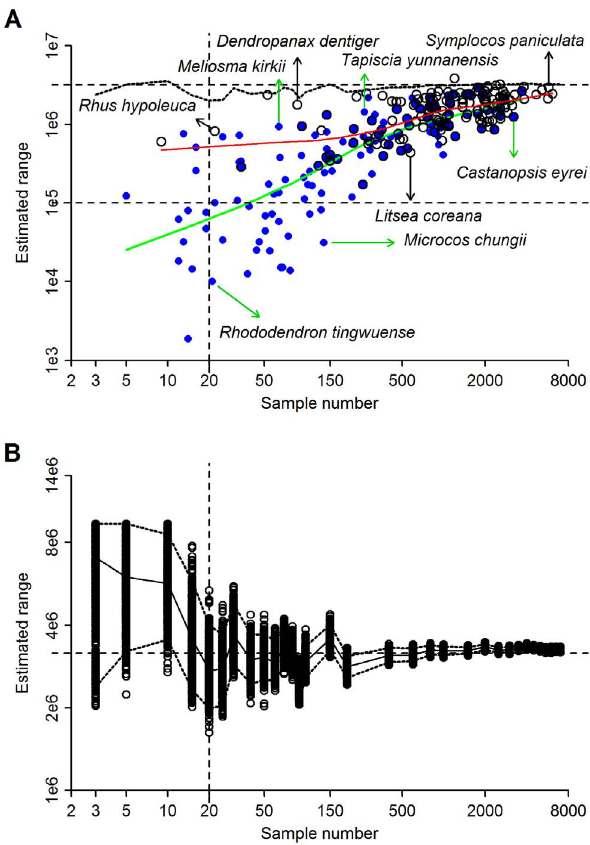
Figure 3. Relationship between estimated range size and sample size of geo-referenced records. Panel A is for real species, and Panel B for random draws from the entire pool of geo-referenced records. In panel A, solid points indicate species from Gutianshan; open circles are for species endemic to China (any of the plots). The green solid line (lower) is a trend curve through the Gutianshan points, and the solid red (upper) line through the endemics. The dotted curve is the lower 95% confidence limit of random ranges (from Panel B). Panel B is a test for bias in estimated range size caused by sample size. The solid, central curve is the mean range size from 1000 draws at each value of N (sample number of geo-referenced records), and two dotted curves are 95% confidence intervals (the central 95 percentiles of 1000 draws). Samples were done at N =3, 5, 10, 15, 20, 25, 30, 40, 50, 60, 70, 80, 90, 100, 150, 200, 400, 600, 800, 1000, 1500, 2000, 2500, 3000, 3500, 4000,